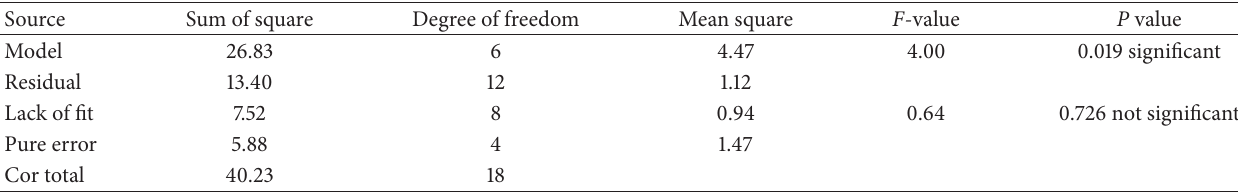
Table 3: Analysis of variance for fitted 2FI polynomial model.